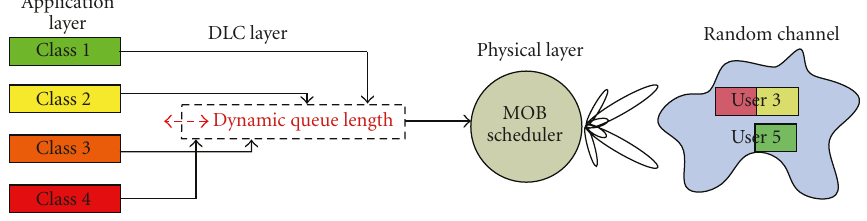
Figure 1: Dynamic queue length scheme.